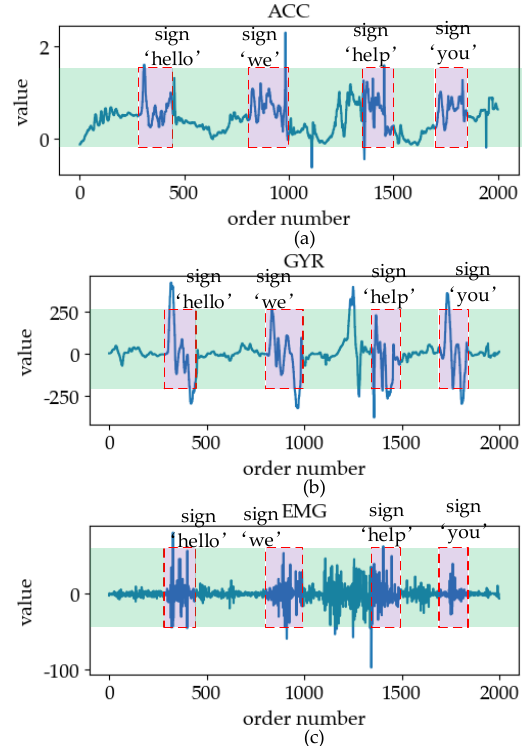
Figure 16. sEMG signal of online sign language data. Two-thousand data points for the whole online sign language signal intercepted are depicted in the figure, wherein the red box is the effective region of sign language data.